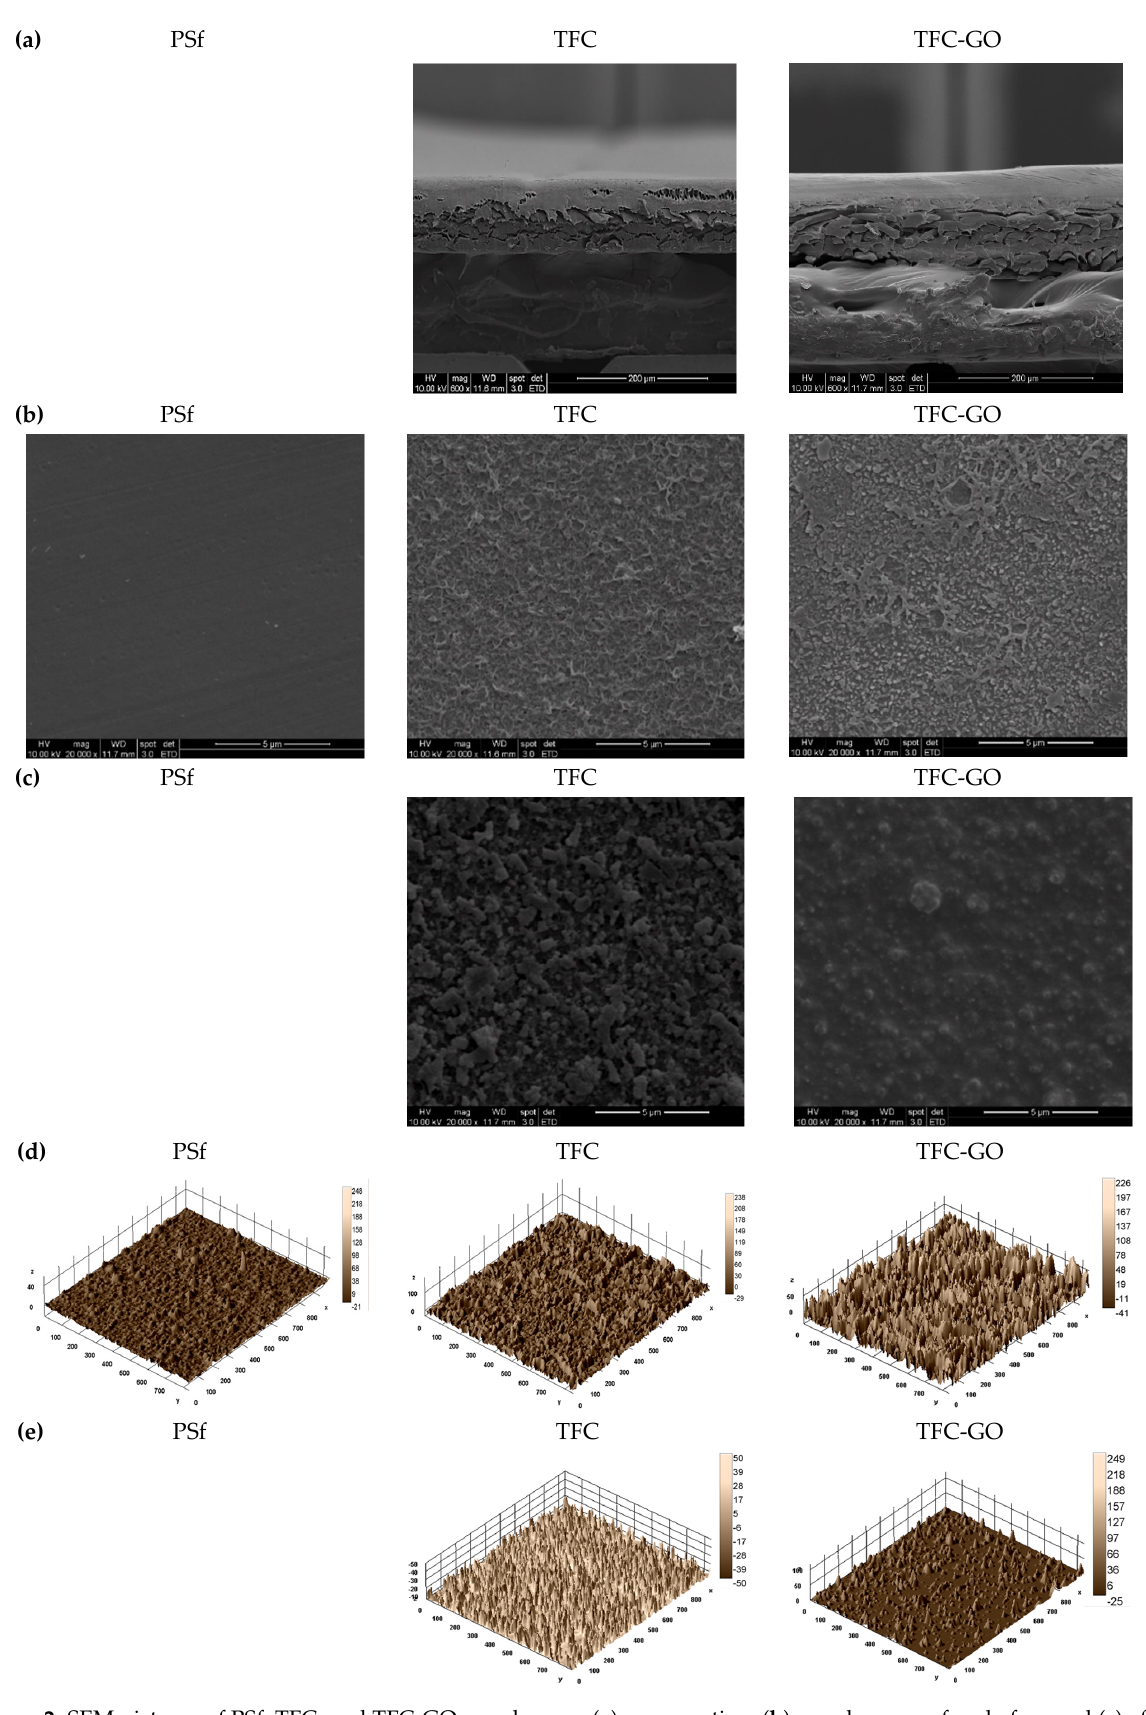
Figure 2. SEM pictures of PSf, TFC, and TFC-GO membranes: ( a ) cross-section, ( b ) membrane surface before and ( c ) after H 2 O 2 exposure (20,000×), and ( d ) 3D images before and ( e ) after H 2 O 2 exposure. Table 2. Surface characteristics of the fabricated TFC and TFC-GO membranes.